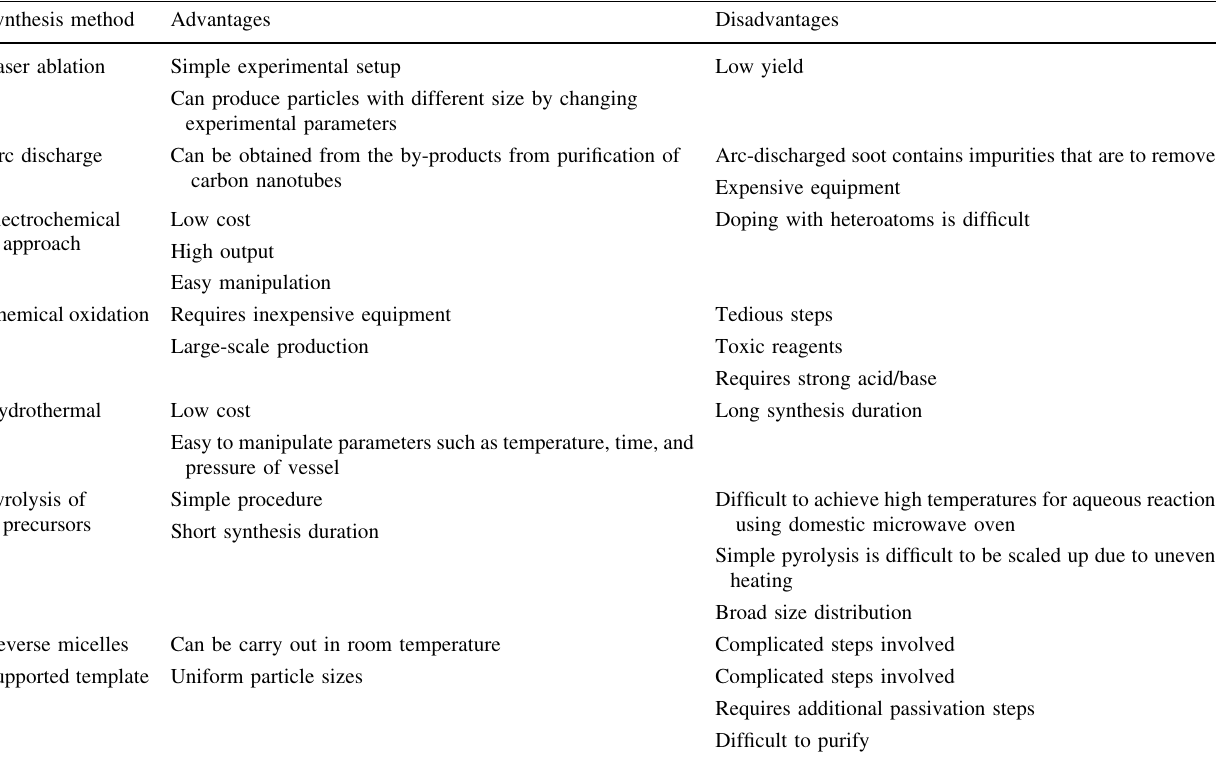
Table 1 Summary of the advantages and disadvantages of different synthesis methods Synthesis